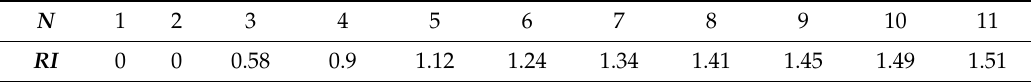
Table 2. Random consistency index ( RI